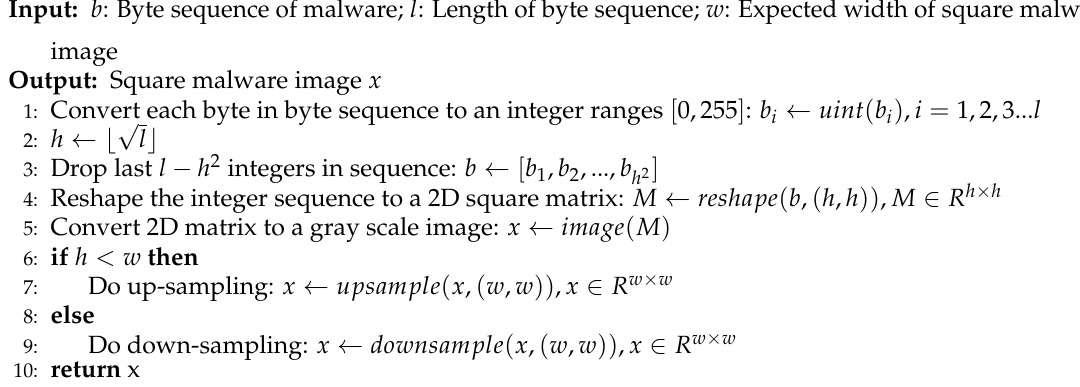
Algorithm 1 Conversion from malware to